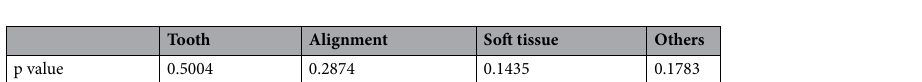
Table 4. Kruskal–Wallis test of the differences between each resolution. No significant differences have been found in the number of counts of each discriminative part of